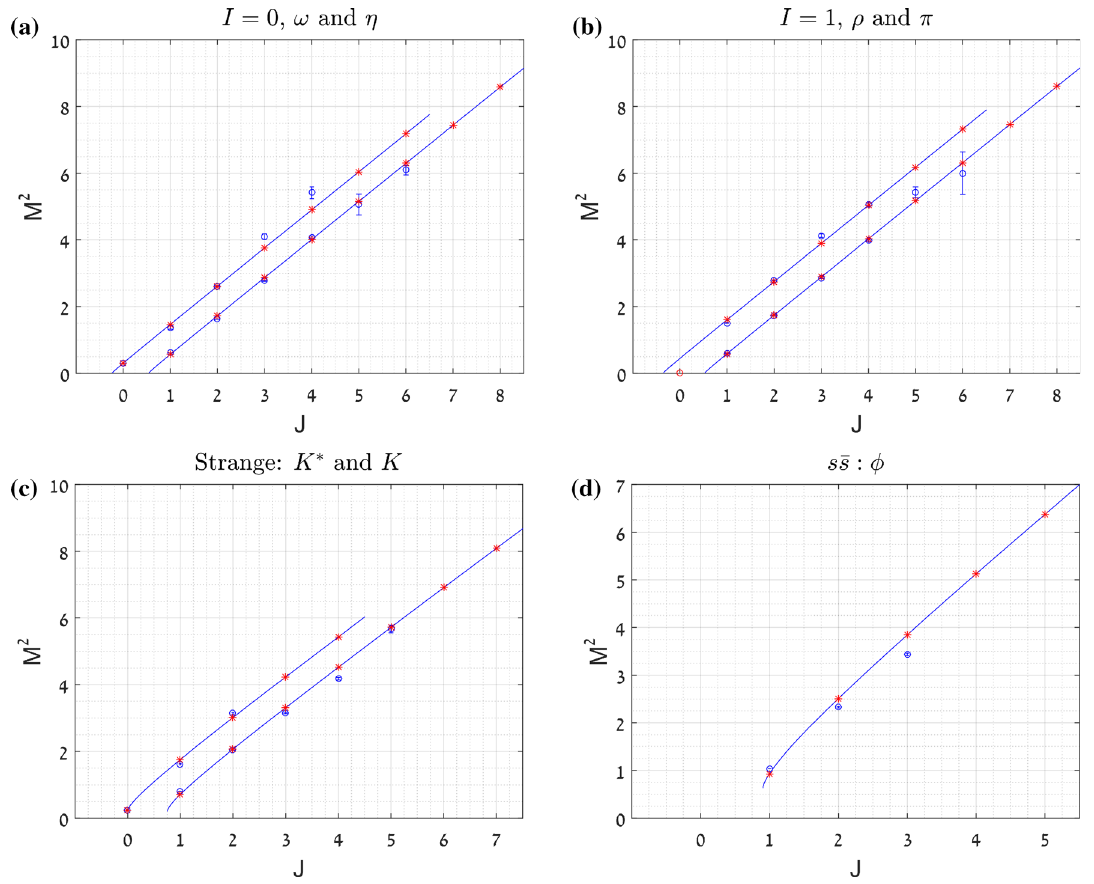
Fig. 3 The leading orbital modified Regge trajectories of light mesons, fitted with the common slope α (cid:2) = 0 . 88 GeV − 2 . All the states fitted are listed in the appendix in Table 14. In blue are the data points, and the red asterisks along the trajectory are the theoretical